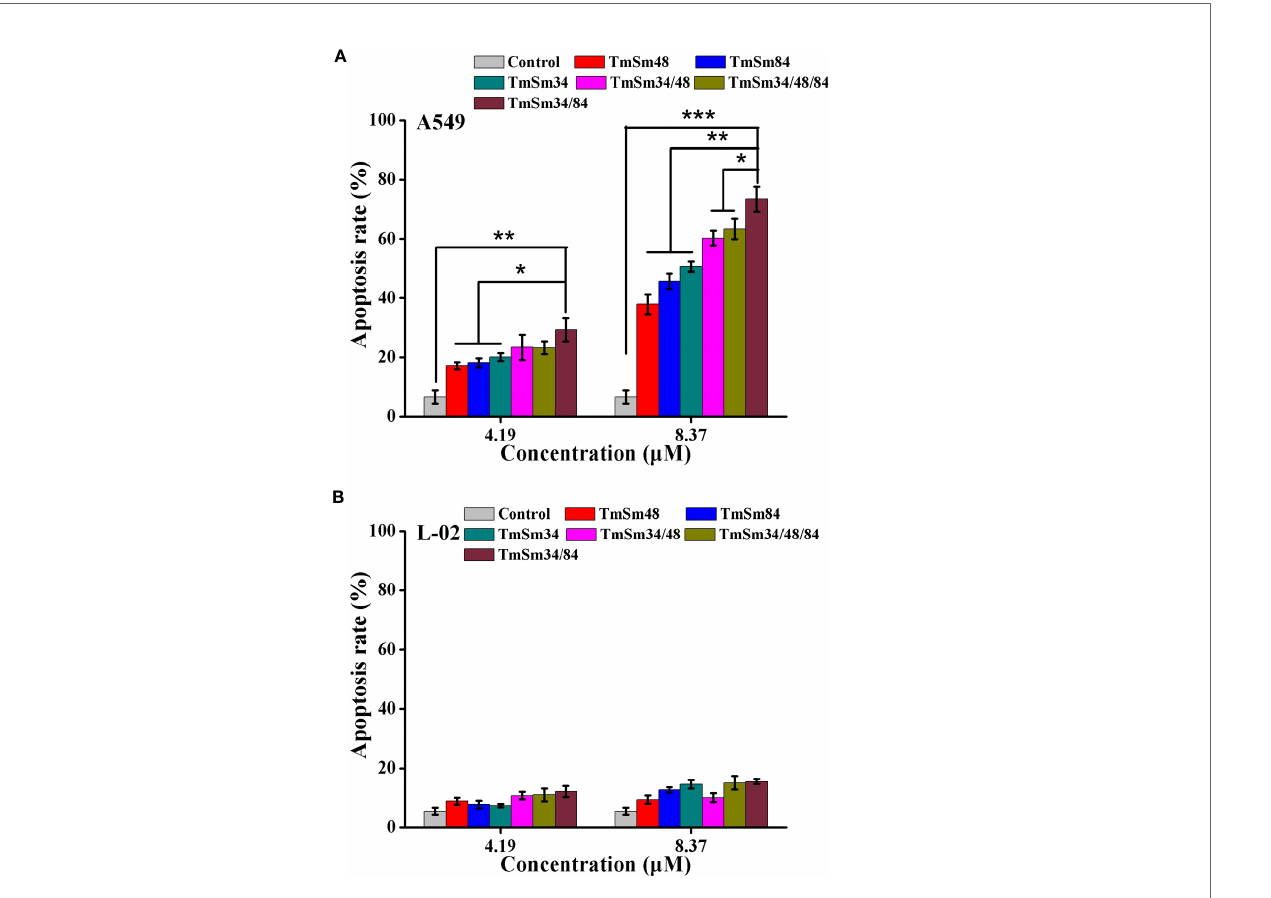
FIGURE 3 | Apoptosis of A549 and L-02 cells were analyzed by fl ow cytometry. (A) A549 cells were incubated with different TmSm proteins of the same concentrations gradient (0, 4.19, and 8.37 m M) for 24 h. Bar diagram depicting the total percentage of apoptotic cells. (B) L-02 cells were incubated with different TmSm proteins of the same concentrations gradient (0, 4.19, and 8.37 m M) for 24 h. Bar diagram depicting the total percentage of apoptotic cells. Data were expressed as mean ± SD ( n = 3). * P < 0.05, ** P < 0.01, and *** P <